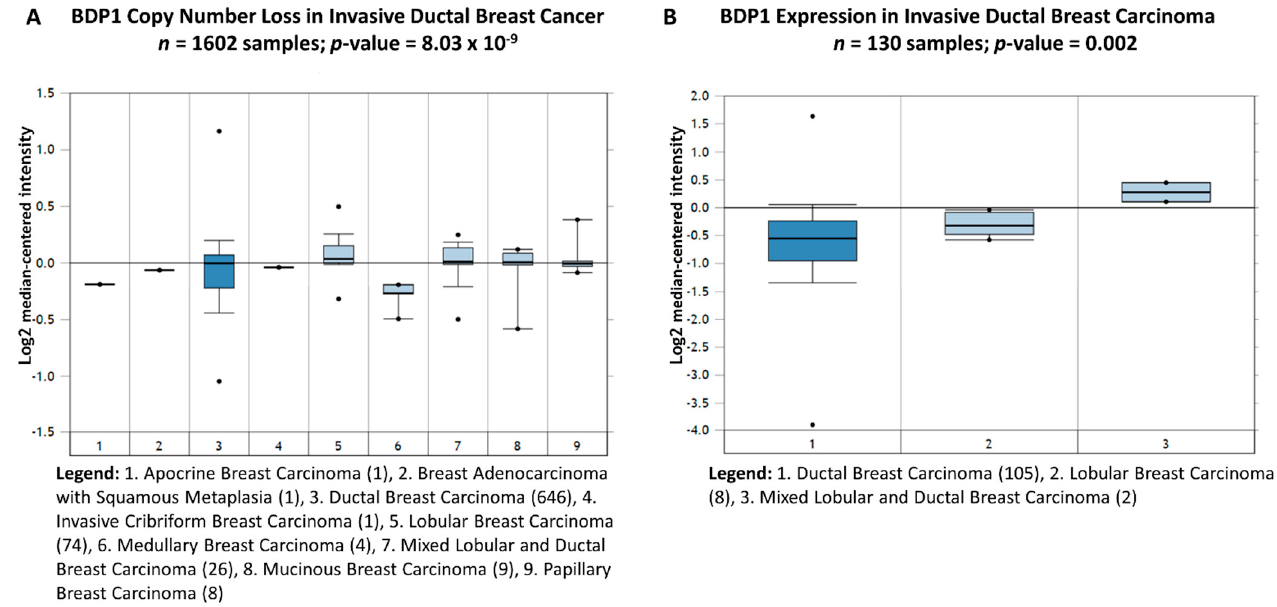
Figure 1. BDP1 DNA copy number and mRNA expression decrease in invasive ductal